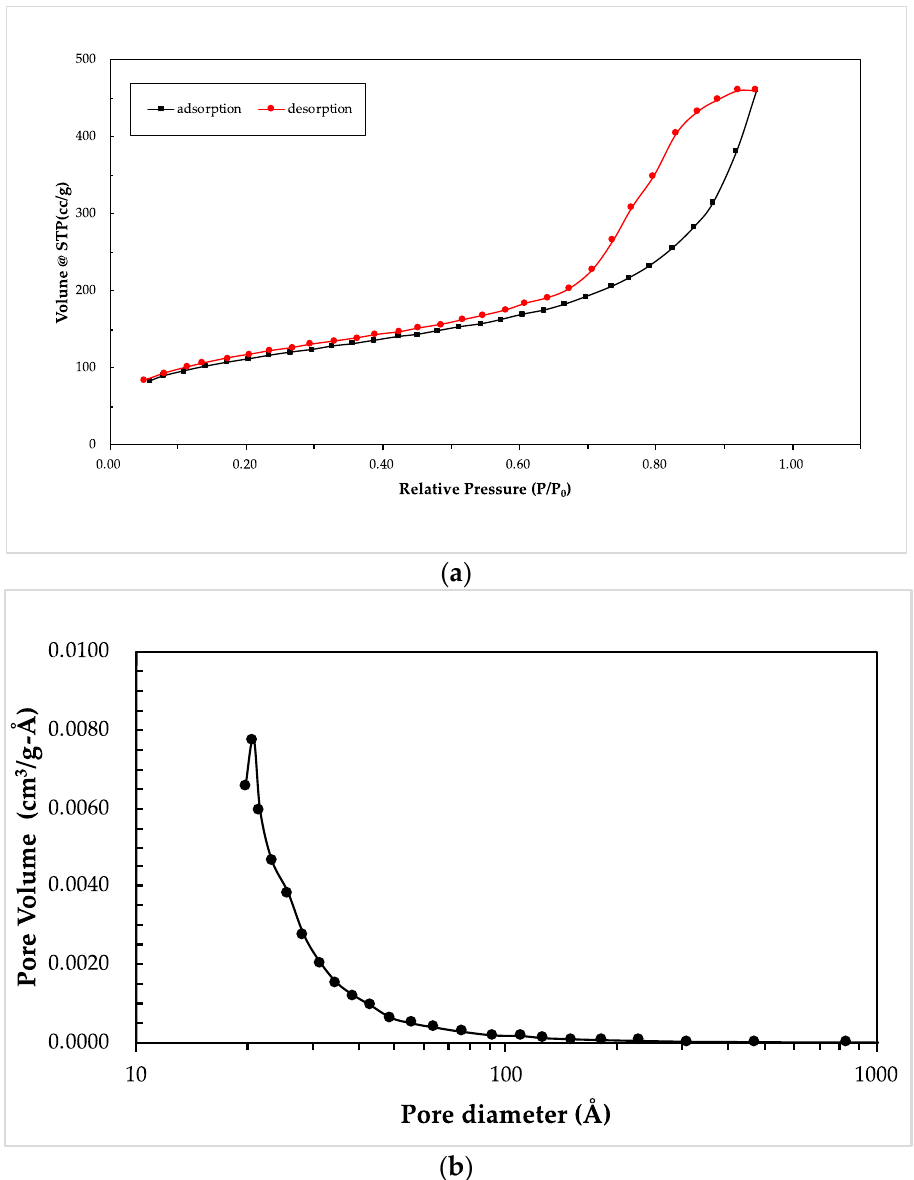
Figure 5. ( a ) Nitrogen adsorption–desorption isotherms and ( b ) pore size distribution curve of the aerogel porous board.